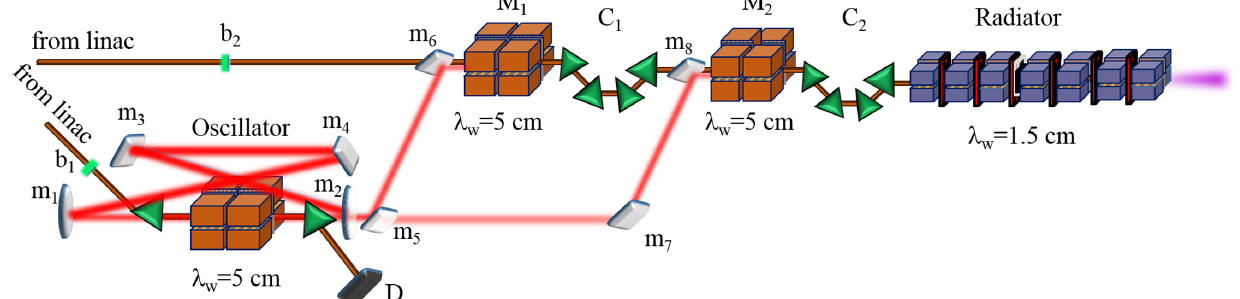
FIG. 1. Scheme of the echo-enhanced harmonic generation FEL. b 1 and b 2 : electron bunches alternatively sent in the oscillator and in the undulators. FEL Oscillator undulator: λ w ¼ 5 cm, a w ¼ 3 . 71 , total length 9 m. m 1 , m 2 , m 3 , m 4 : oscillator cavity mirrors. D: beam dump. m 5 , m 6 , m 7 , m 8 : mirrors of the optical line that splits and couples the seed to the modulators. m 2 and m 5 : beam splitters. First ( M 1 ) and second ( M 2 ) modulators: λ w ¼ 5 cm, a w ¼ 3 . 71 , respectively 1.6 m and 1.5 m long. The two chicanes C 1 ; 2 are both 0.45 m long.